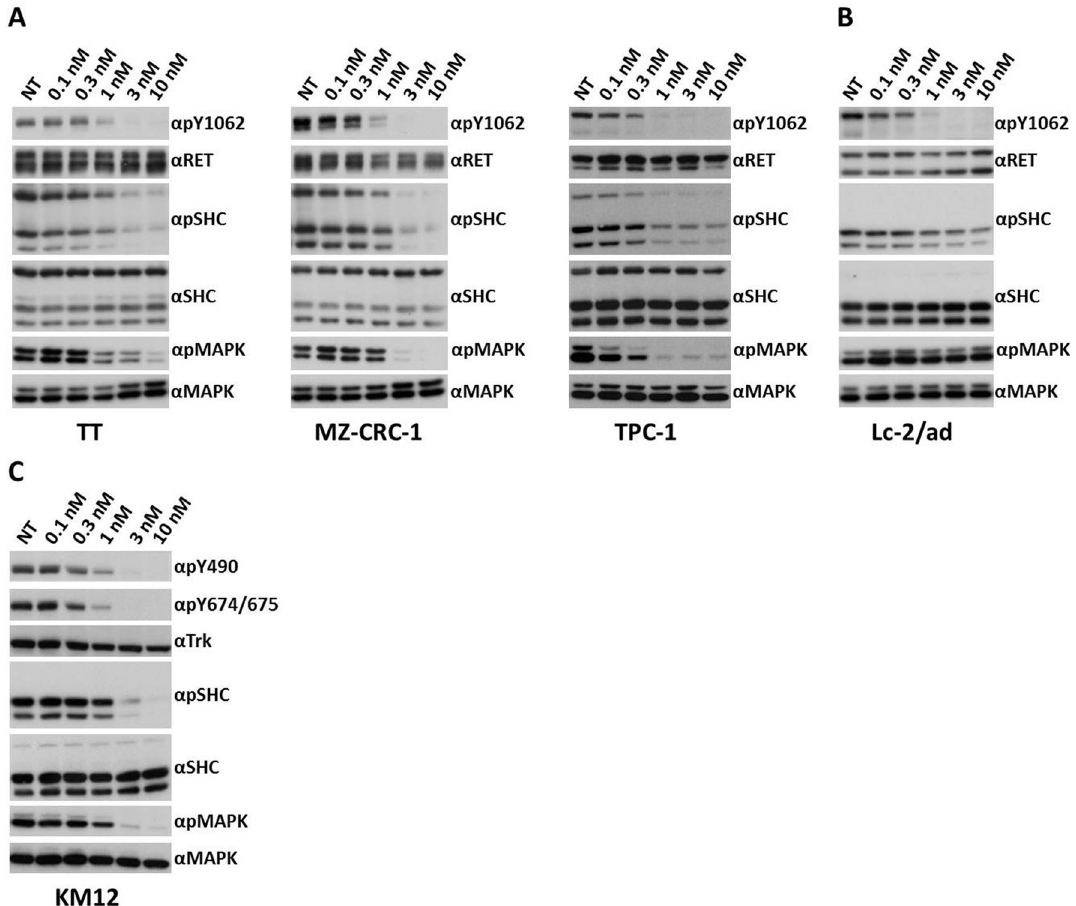
Figure 2. Serum-starved RET-positive thyroid cancer cell lines TT, MZ-CRC-1, TPC-1 ( A ), RET-positive lung cancer cell line Lc-2/ad ( B ) and TRKA-positive colon cancer cell line KM12 ( C ) were treated for 2 h with the indicated concentrations of Pz-1. Total cell lysates (50 μg) were subjected to immunoblotting with the indicated